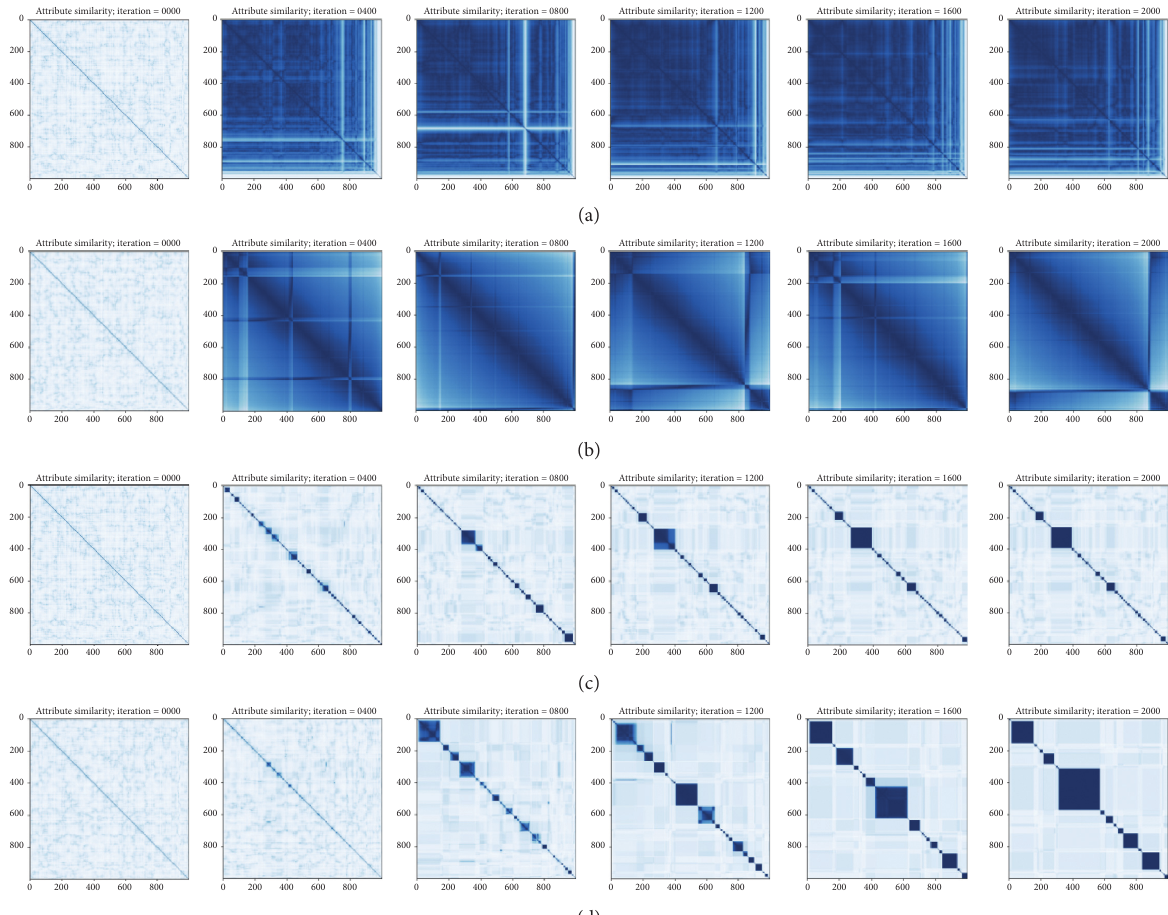
Figure 8: Evolution results of the state similarity matrix. The similarity matrix element sim based on equation (2) and uses the color to represent the size of sim i,j . The figure shows the state similarity matrix of the two networks when the number of iterations is 0, 400, 800, 1200, 1600, and 2000. (a) ER network ( θ � 0.15). (b) BA network ( θ � 0.15). (c) ER network ( θ � 0.35). (d) BA network ( θ �